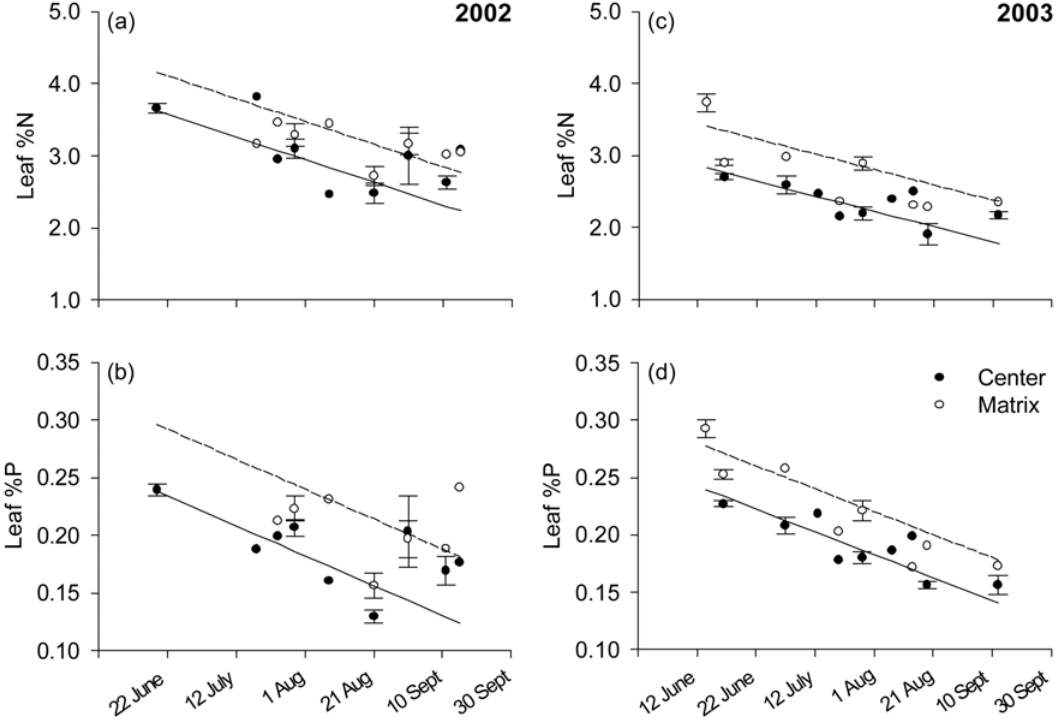
Figure 4. Leaf nutrient concentrations over the 2002 (a and c) and 2003 (b and d) growing seasons, by location. Each point is from a homogenized bulk collection sampled from many plants. Points with error bars represent the mean ( 6 SE) of samples from multiple sites on that date (data from each sample were used in the regression analysis). Matrix refers to low-density areas being colonized by lupins. Plants from matrix areas were much richer in both %N and %P in both years ( P , 0.0002; see Table 2). Least squares fits are shown by solid (center) and dotted (matrix) lines.